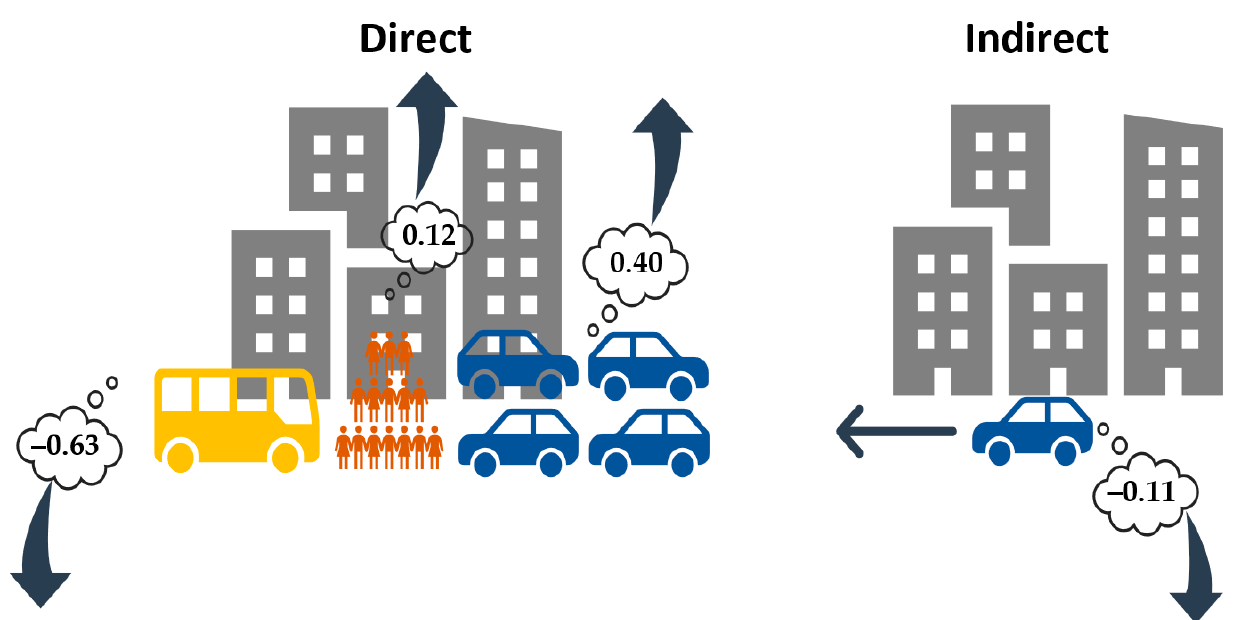
Figure 5. Flow diagram of direct and indirect spatial effects of the number of vehicles, population density, and greater use of buses with respect to private cars on 𝑁𝑂𝑥 emissions.